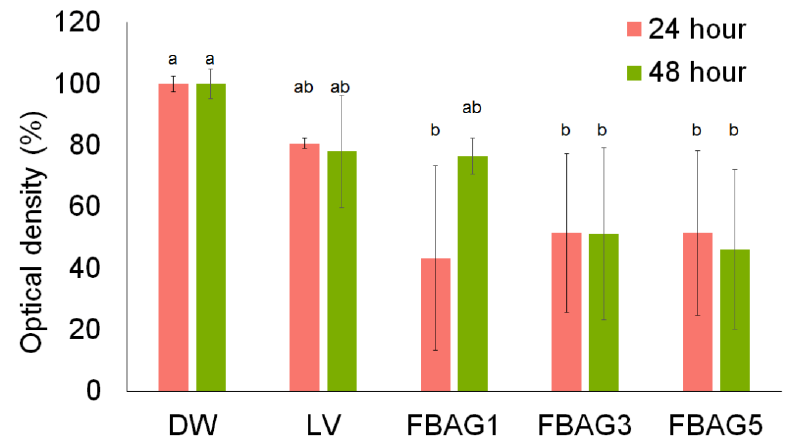
Figure 8. The difference in antibacterial properties between cured LV and FBAG orthodontic bonding pastes at 24 and 48 h. The same letter indicates no statistically significant difference between the groups (p < 0.05) by Duncan’s multiple comparison test. Error bars are shown ± standard error.